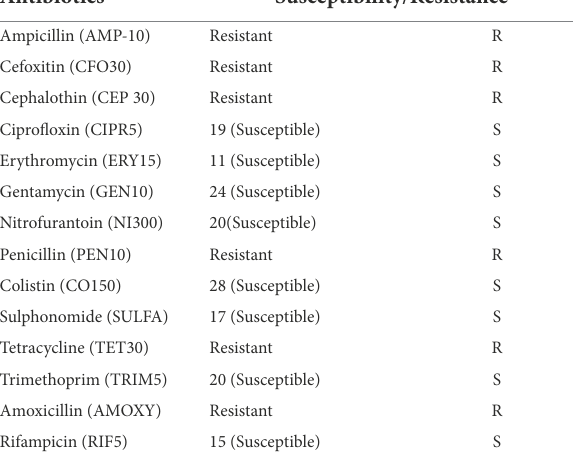
TABLE 3 Antimicrobial resistance of Aeromonas media strain SD/21– 15 based on disc diffusion test. Antibiotics